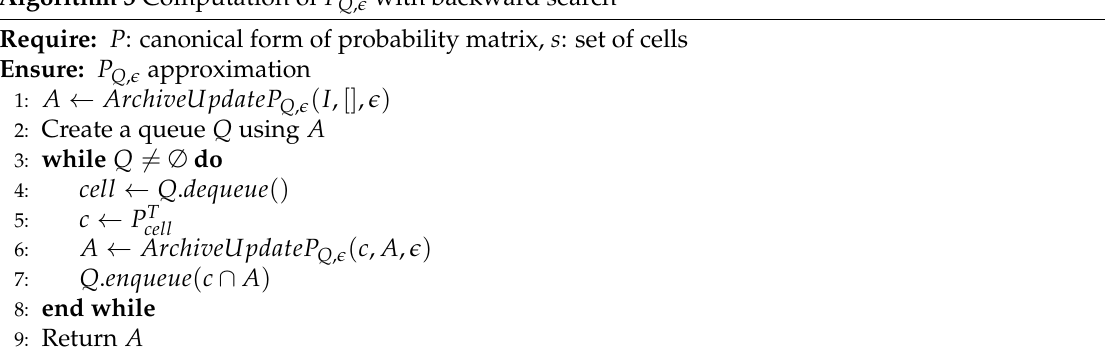
Algorithm 3 Computation of P Q , (cid:101) with backward